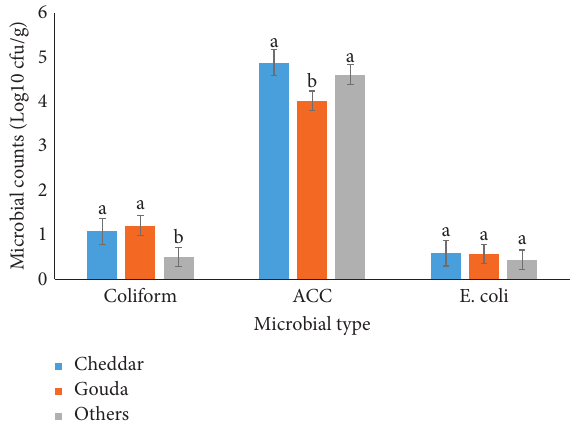
Figure 2: Microbial counts according to aging months. Different superscripts indicate a significant difference across months ( P < 0 . 05). ACC: aerobic colony count; E. coli : Escherichia coli.